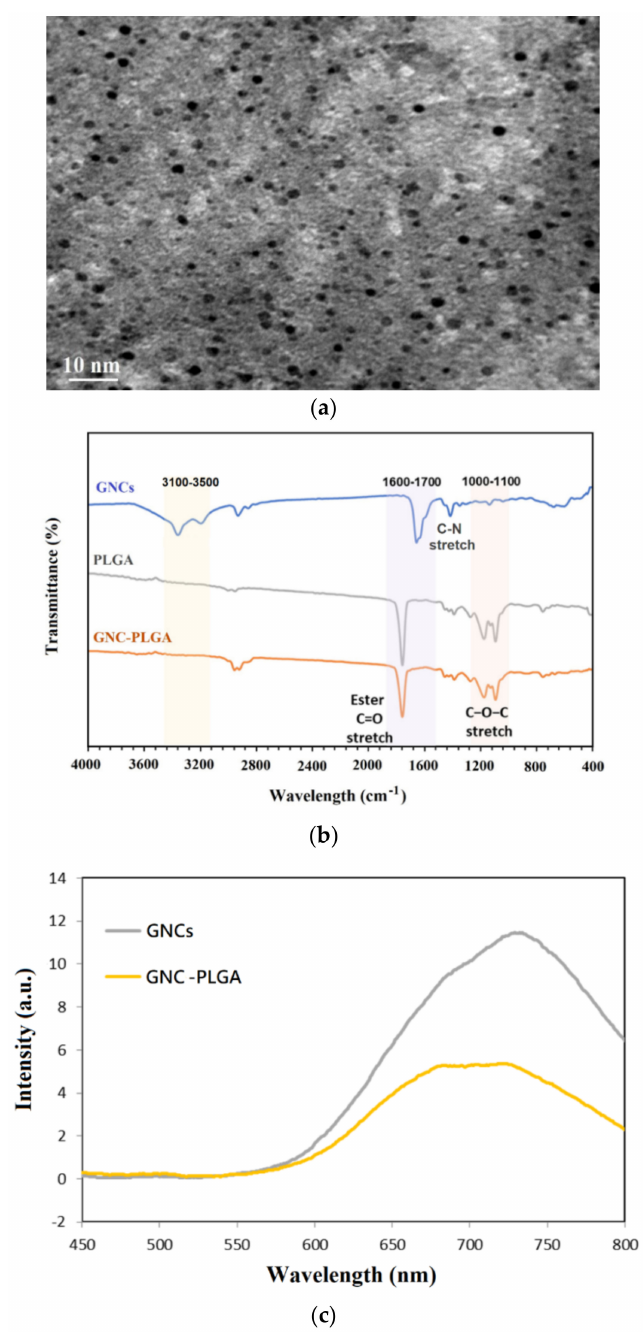
Figure 2. TEM images of fluorescent gold nanoclusters (GNCs) ( a ); FTIR spectra of GNCs, PLGA, and GNC-PLGA ( b ); fluorescence emission (excitation at 350 nm) spectra of GNC colloid and GNC-PLGA solution ( c